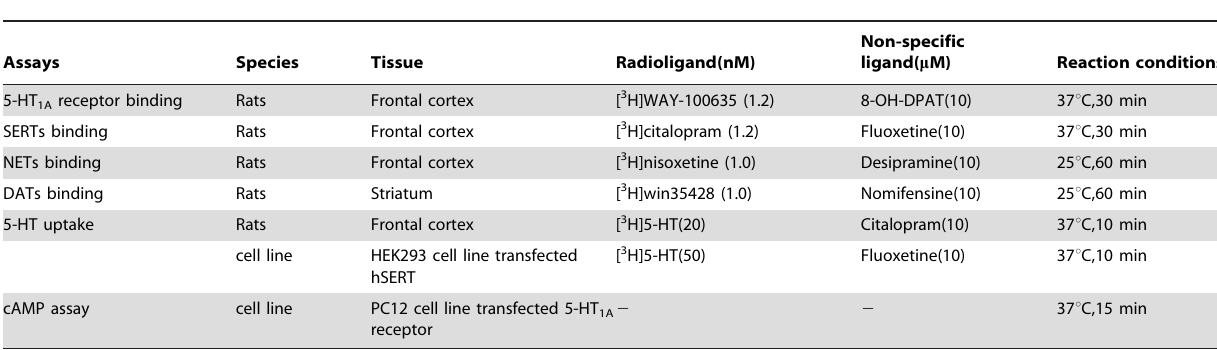
Table 1. The specific parameters in binding and uptake